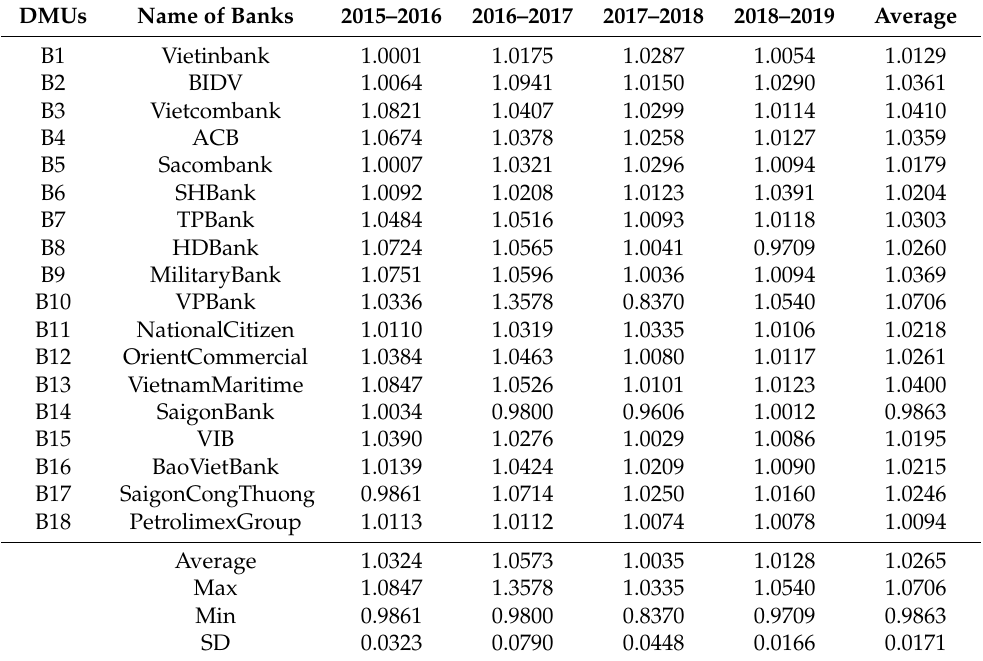
Table 6. The technological change